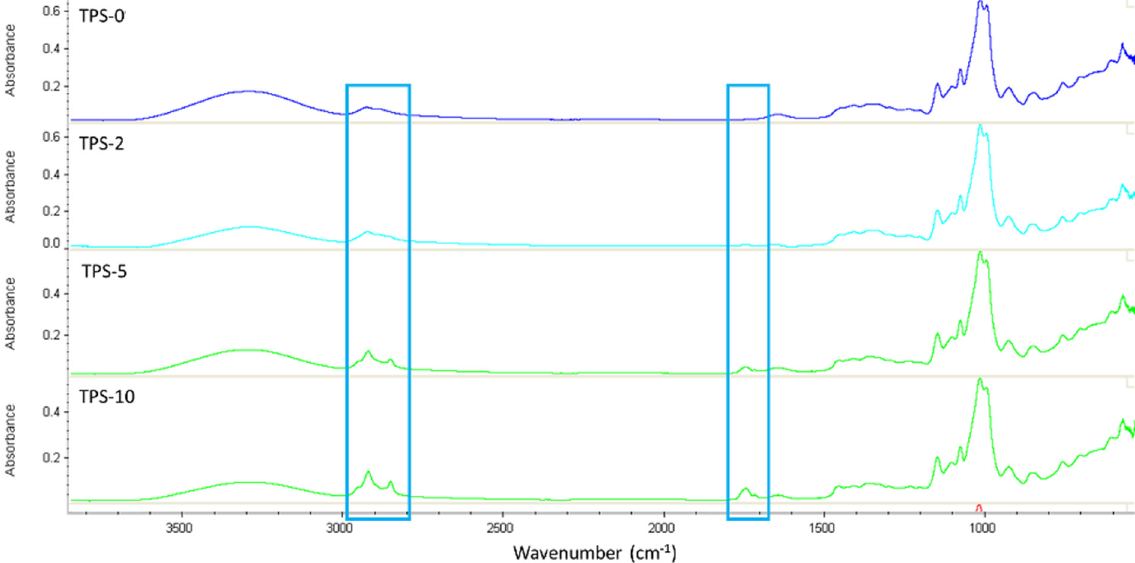
Figure 3. FTIR spectra of TPS/FASE blends (from top to bottom: TPS-0, TPS-2, TPS-5, and TPS-10. FTIR analyses were performed on the surface and at 1/3rd of the thickness below the surface after cutting out the surface. Figures 4 and 5 compare the FT-IR spectra at the core and the surfaces (upper and lower), respectively, for a TPS-5 film and a TPS-10 film.